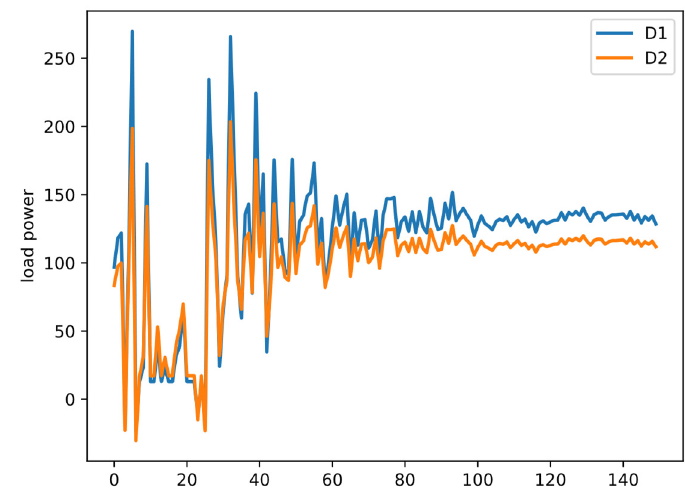
15 of 23 Figure 5. Noise variation added by system action parameters .